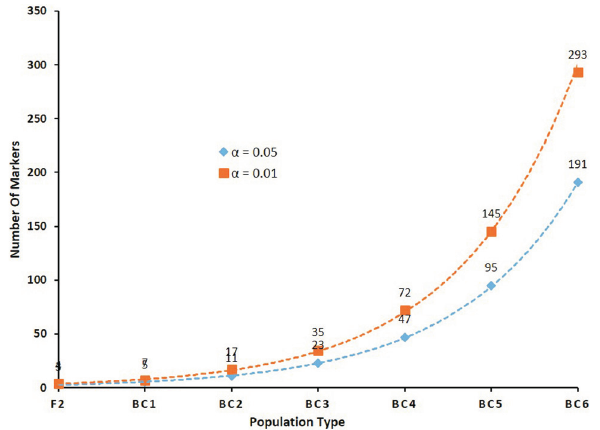
Figure 4 - Estimated numbers of independent bi-allelic markers expected for correctly identifying hybrid individuals in different intercross and backcross populations between a target and a non-target species based on